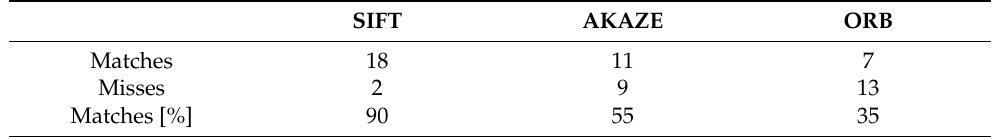
Table 4. The number of correct matches among the 20 pairs of images when using SIFT, AKAZE, and